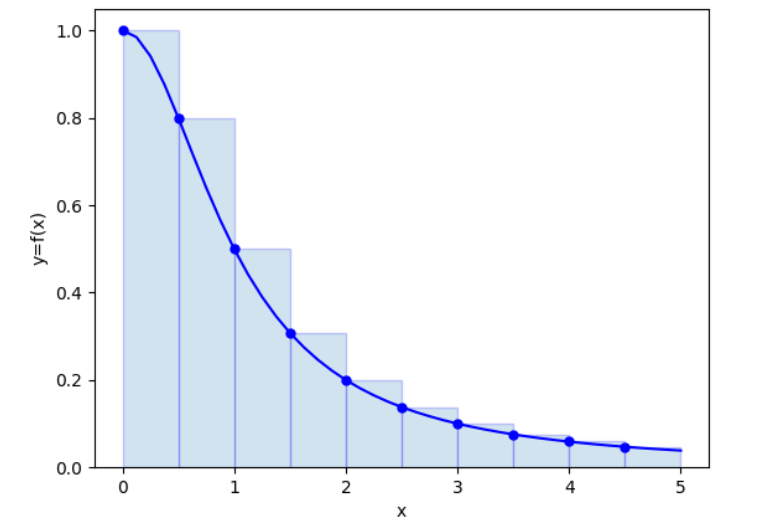
Figure 9. Examples of the Reimann